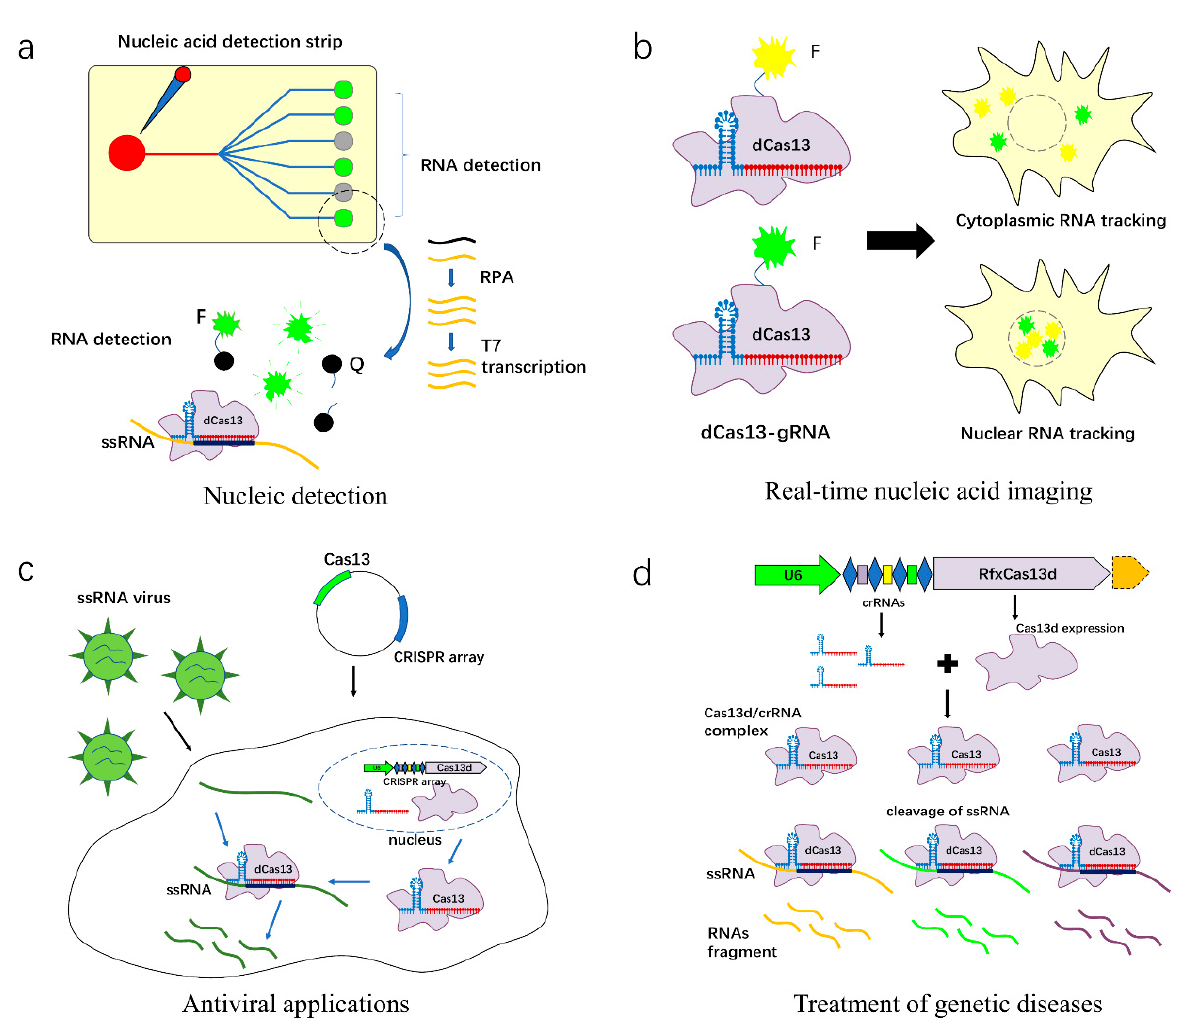
Figure 4. Applications of CRISPR-Cas13 system . ( a ). Cas13-driven biosensor for disease diagnosis. Cas13-based DNA and RNA detection methods and sample preparation steps are integrated into microfluidic biosensors for rapid pathogen detection; ( b ). Real-time nucleic acid imaging and tracking of living cells using type VI CRISPR systems. dCas13 proteins fused with fluorescent proteins (FPs) effector and coupling with specific guide RNA can be used for spatiotemporal visualization of the target RNA transcripts in living cells; ( c ). Antiviral application of type VI CRISPR systems. The type VI CRISPR systems target the genomic region of evolutionarily conserved ssRNA viruses to inhibit viral infection in human animals and plants; ( d ). CRISPR-Cas13 system-mediated genetic disease